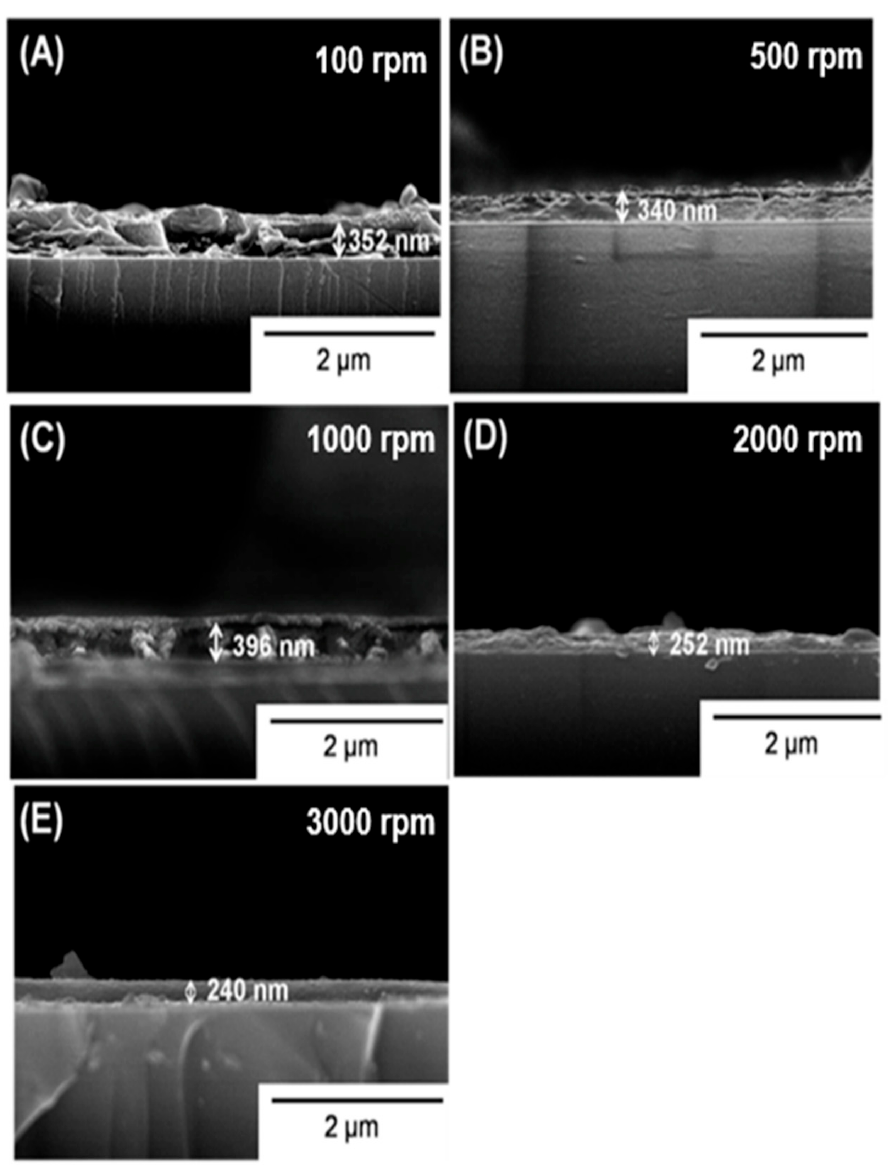
Figure 5. Cross-section FE-SEM of CuCrO 2 thin films deposited on glass substrates at different rotating speed and annealed at 600 °C for 10 min. Speed of rotation: ( A ) 100 rpm, ( B ) 500 rpm, ( C ) 1000 rpm, ( D ) 2000 rpm, ( E ) 3000 rpm .